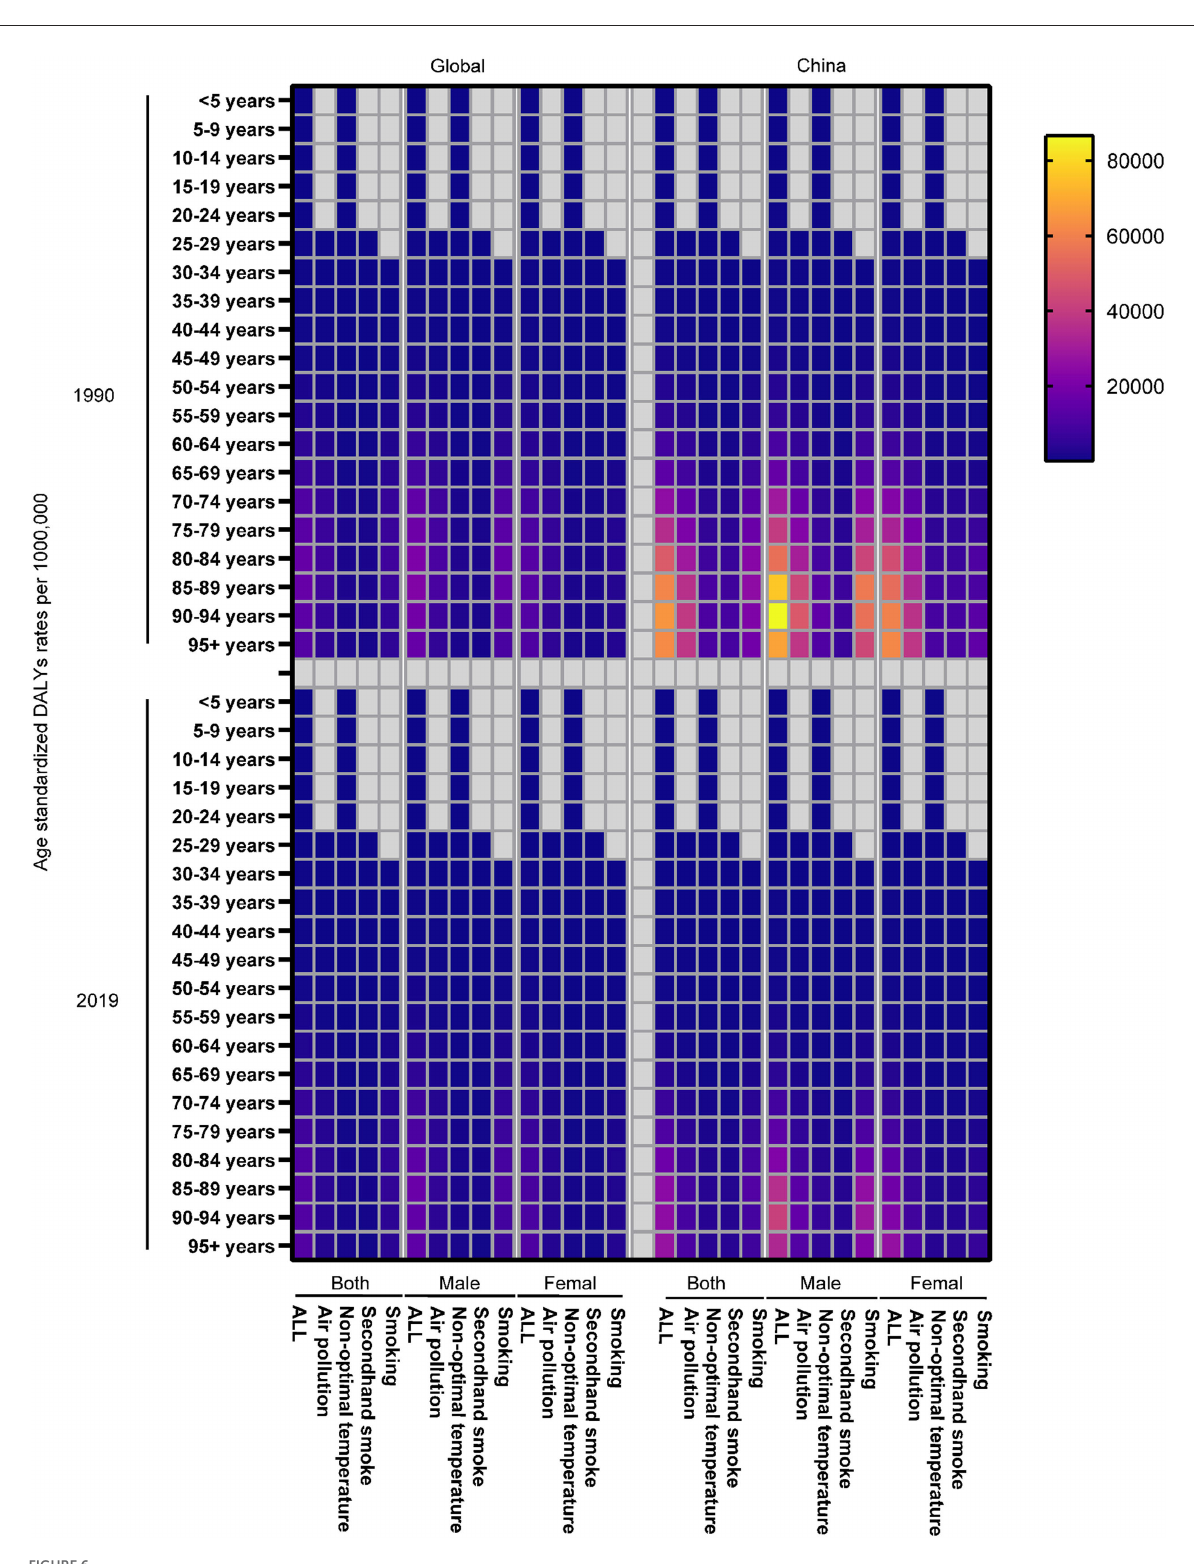
FIGURE6 The ASR of COPD DALY attributable to risk factors in different ages in 1990 and